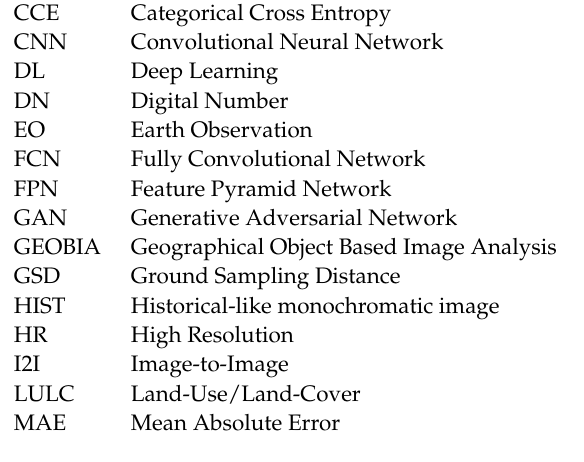
Figure S2 : Examples of the MiniFrance dataset (tile dimensions are 10,000 × 10,000 px²); Figure S3 : Validation examples of image-to-image translation between the MiniFrance (RGB) and Sagalassos 1981 historical orthophoto (panchromatic, PAN) domains using CycleGAN trained for 10 epochs; Figure S4 : Validation examples of image-to-image translation between the MiniFrance (RGB) and Sagalassos 1981 historical orthophoto (panchromatic, PAN) domains using CycleGAN trained for 50 epochs; Figure S5 : Examples of image-to-image translation between the MiniFrance (RGB) and Sagalassos 1981 historical orthophoto (panchromatic, PAN) domains using the mapping function learned between the Sagalassos 2015 and 1981 domains using CycleGAN; Figure S6 : Example image patches of the Sagalassos 2015 validation set (CycleGAN translated) with corresponding LULC ground truth and prediction. The black regions in the ground truth are due to our data augmentation technique (Section 3.3.4); Figure S7 : Confusion matrix for the Sagalassos 2015 validation set using the UNet-EffB5 architecture, MiniFrance-hist pretraining and SAG15-hist fin. conv. fine-tuning. Values sum to 100% over the true label.; Figure S8 : Confusion matrix for the MiniFrance-historical (CycleGAN translated) dataset. Values sum to one over the true label. Nan-values are because these two classes do not appear in the dataset despite being mentioned in the dataset